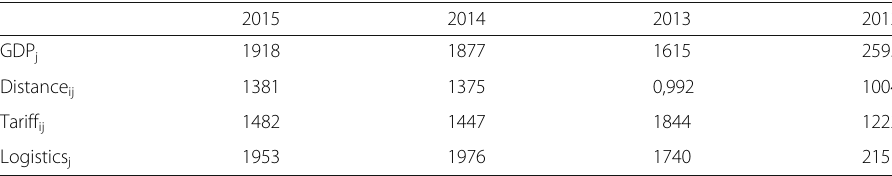
Table 3 Variance inflation factors